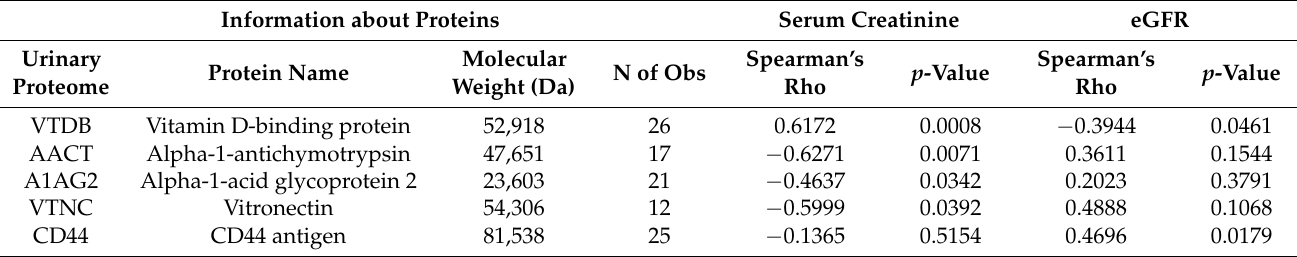
Table 3. Correlations of Serum Creatinine level and eGFR with emPAI of some